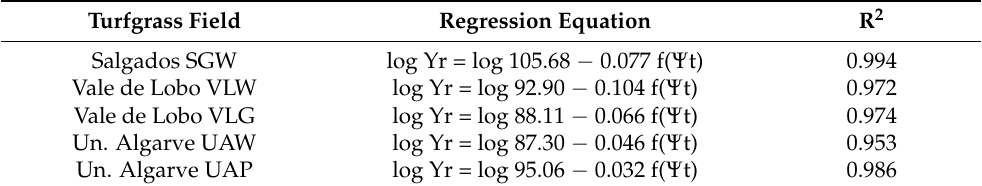
Table 8. Regression analysis of the relationship between turfgrass relative yield Yr (%) and a function of the soil total water potential f( Ψ t).